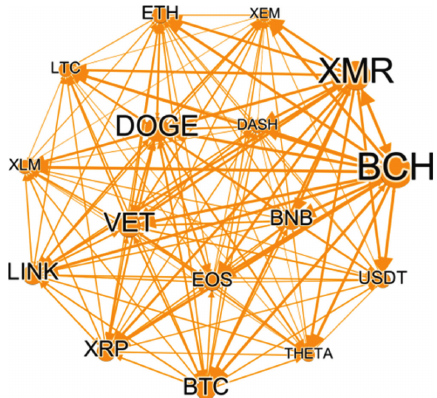
Figure 43: Risk spillover under R5.